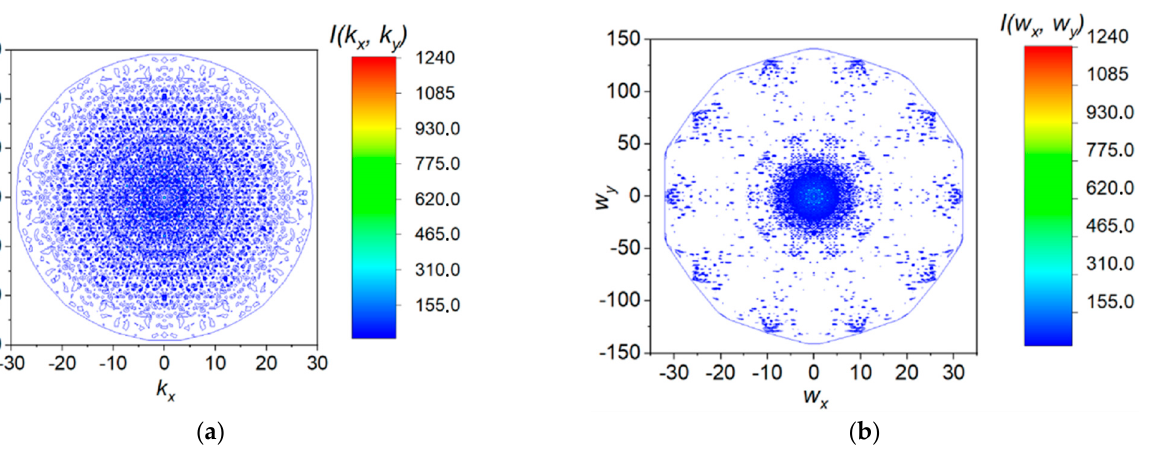
Figure 6. ( a ) Diffraction pattern of the AlCuRh decagonal quasicrystal (synchrotron data after [22]). ( b ) Reduced diffraction pattern of the AlCuRh decagonal quasicrystal. Values on axes shown in